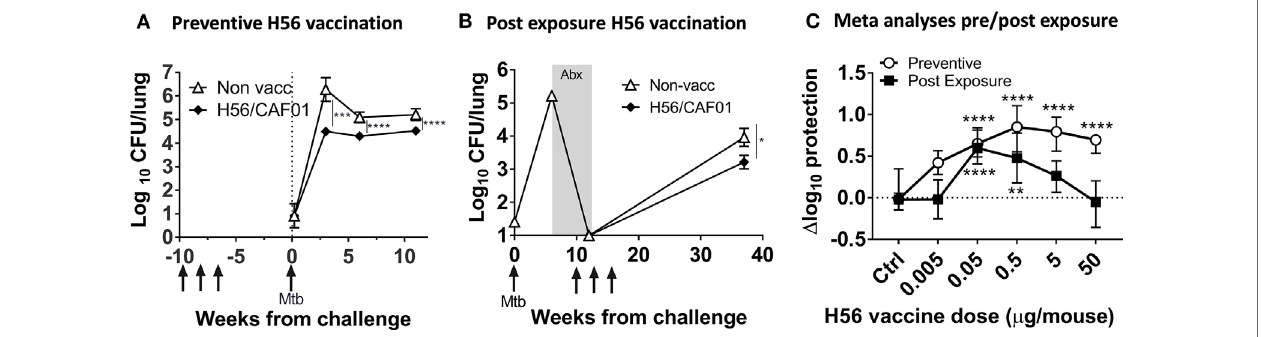
FigUre 1 | High dose H56 in post-exposure vaccination is detrimental to protection against Mycobacterium tuberculosis (Mtb). Total lung bacterial burden (log 10 CFU) for unvaccinated control (open triangle) and 5 µg H56 in CAF01 vaccinated (closed diamond) mice in preventive (a) and post-exposure (B) vaccination TB protection models. (a) CB6F1 mice were vaccinated (gray arrows) s.c. three times and rested 6 weeks before low dose aerosol Mtb challenge and subsequent lung CFU determination at weeks 3, 6, and 12 post-infection. Symbols represent mean ± SEM of n = 6–8 mice/group. *** p < 0.001, **** p < 0.0001 by two-way ANOVA with Tukey’s posttest for multiple comparisons at each time point. (B) CB6F1 mice were aerosol-infected with Mtb and treated with antibiotics (gray box; Abx) prior to three s.c. H56 vaccinations (gray arrows, weeks 10, 13, and 16) and subsequent CFU determination 37 weeks post-infection. Symbols represent mean ± SEM, n = 4–6 mice/grp (weeks 0–12) and 15/group (week 37). * p < 0.05 Mann–Whitney test at week 37. (c) Meta-analysis of Δ log 10 protection values (see Materials and Methods for calculation) for the indicated H56 dose using combined data from three independent preventive (open circles, 6 weeks post Mtb) and nine independent post-exposure (filled squares, 37 weeks post Mtb) vaccination experiments. Symbols, median ± 95% CI of n = 21–129 mice/group. ** p < 0.01, **** p < 0.0001 by Kruskall–Wallis non-parametric test with Dunn’s test for multiple comparisons (vaccine groups vs. controls, separate analyses for preventive/post-exposure